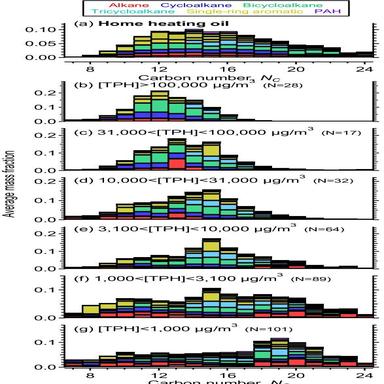
Average mass fractions of hydrocarbon groups of (a) home heating oil, and (b–g) soil gas samples as a function of sample TPH concentrations as labeled, with each concentration bin spanning half an order of magnitude in concentration. Number of samples in each average TPH bin is provided as N in parentheses. Composition is a stacked plot, colored as labeled and in the bottom-to-top order: NDBE = 0 is red with n-alkanes darker, NDBE = 1 is blue with n-alkycyclohexane darker, NDBE = 2 is green, NDBE = 3 is tea